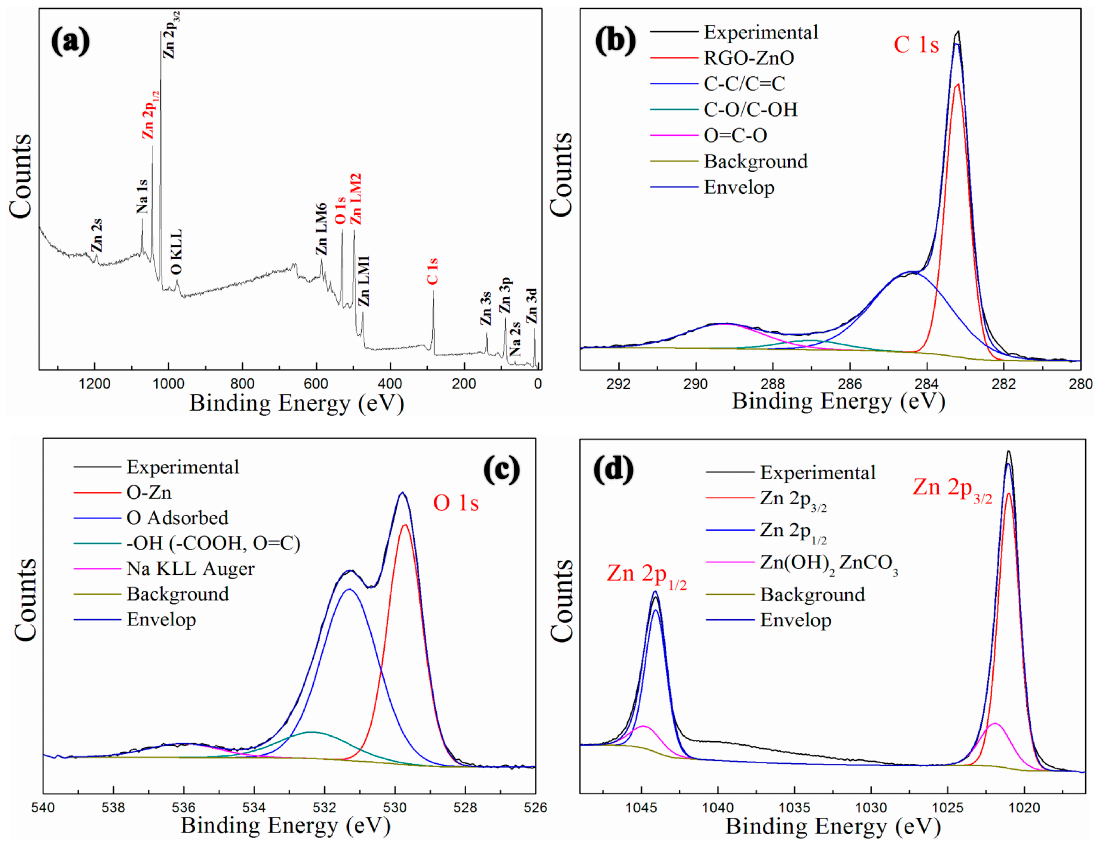
Figure 7. XPS spectrums of GNPs-CNTs-ZnO hybrid: Survey spectrum ( a ), C 1s ( b ), O 1s ( c ), and Zn 2p ( d ).